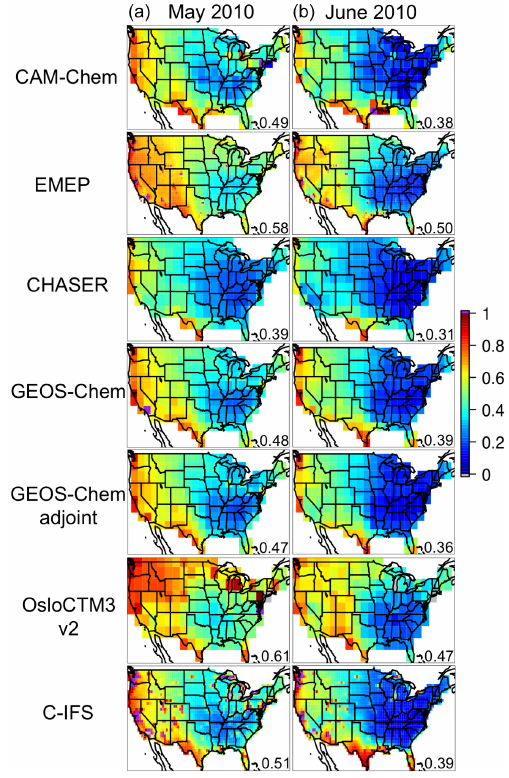
Figure 5. The RERER maps in (a) May and (b) June 2010 over the continental US, calculated based on the monthly mean O 3 from multiple global models’ base and emission sensitivity simulations. The RERER metric (unitless) was defined in Eq. (2) in the text. Values larger than 1 and smaller than 0 are shown in purple and gray, respectively. The US (including continental US as well as Hawaii, which is not shown in the plots) mean values are indicated for each panel at the lower right corner. All models show declining RERER values from May to June, and the seven-model mean RERER values for May and June 2010 are ∼ 0.5 and ∼ 0.4,